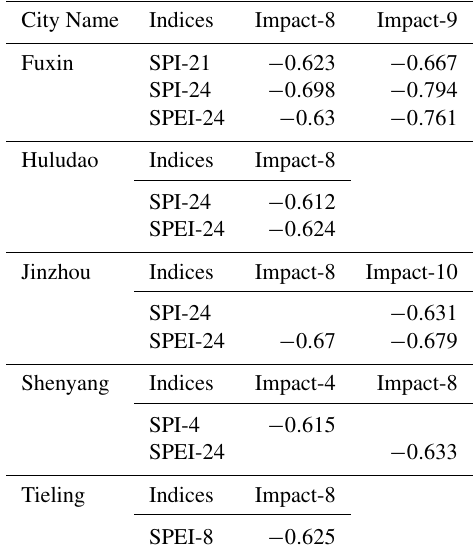
Table 2. Spearman correlation coefficients between drought impact indices in Table 1 to SPI and SPEI with different accumulation pe-